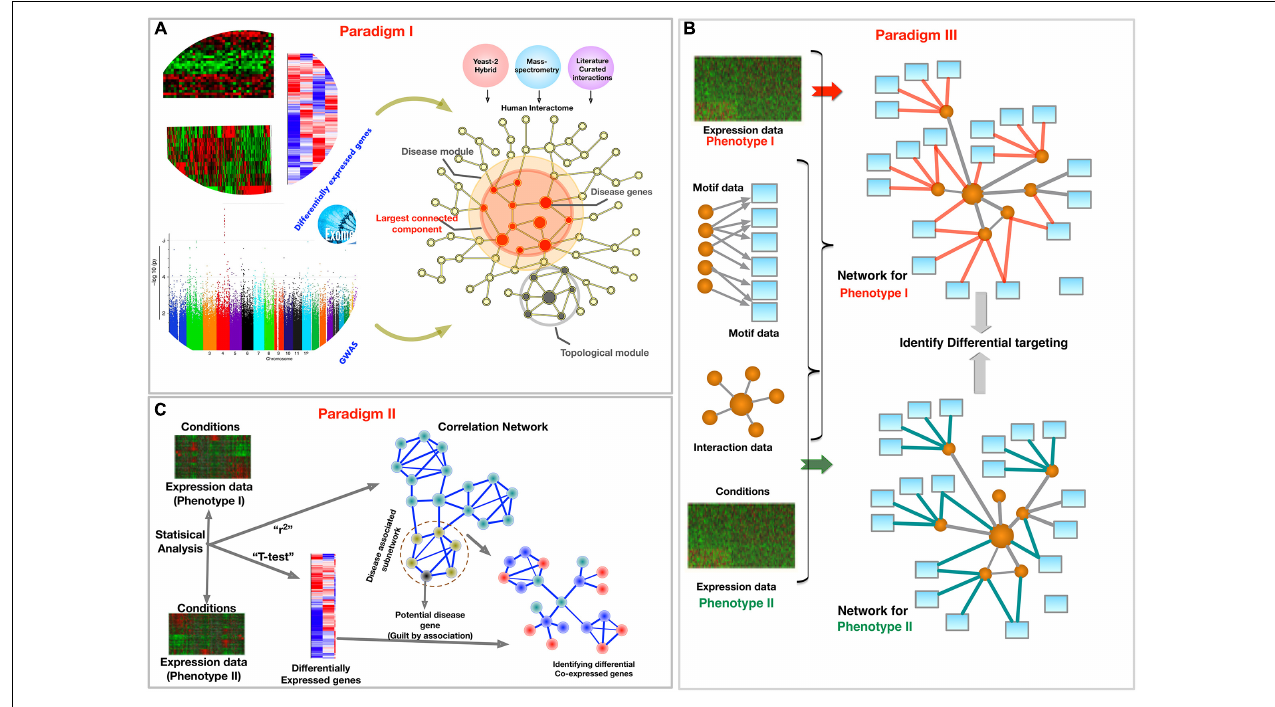
FIGURE 2 | Schematic of three paradigms for combining biological networks with phenotype-specific biomedical data, such as a set of disease genes and transcriptomic profiles for case and control groups. (A) Identification of disease associated network components within the interactome, (B) Co-expression based network modeling to identify disease biomarkers, (C) Constructing phenotype-specific GRNs to identify perturbations and condition-specific regulatory